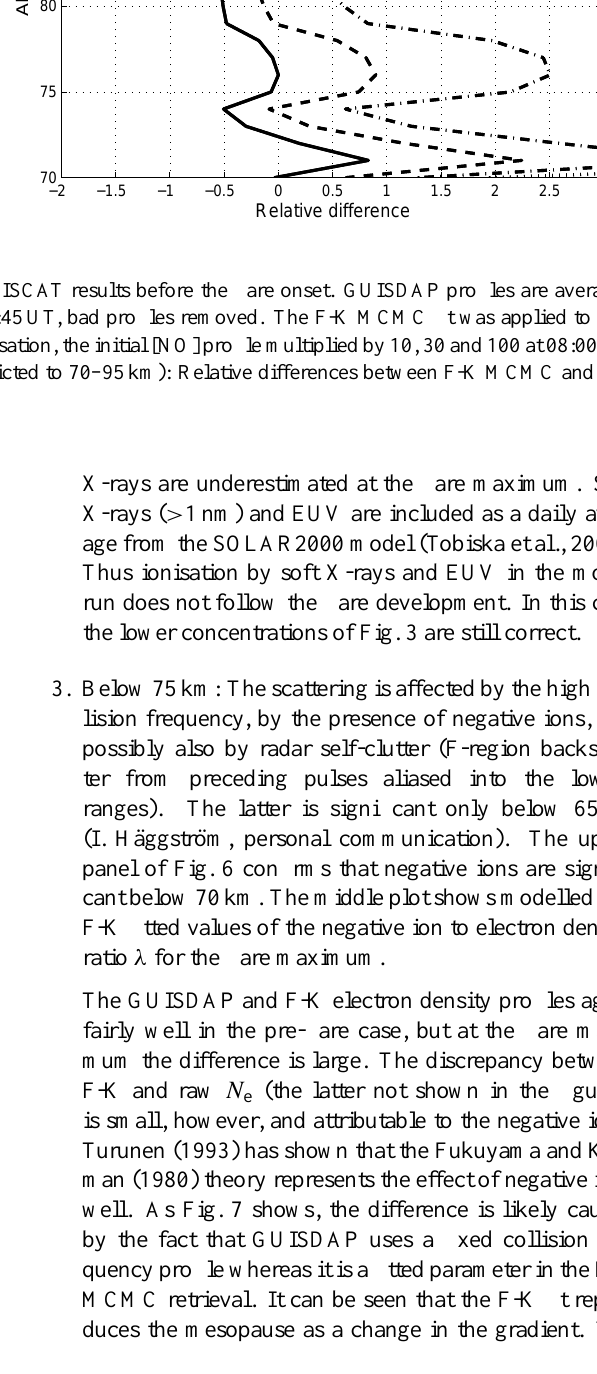
solar protons alone during this period (Verronen et